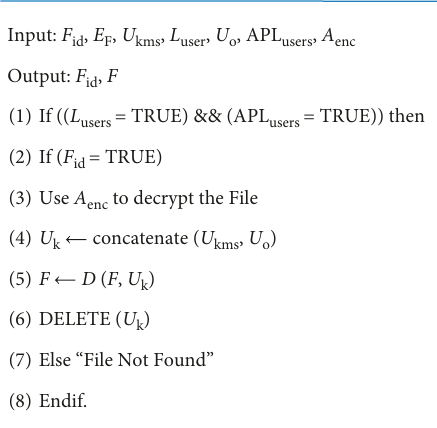
Figure 4: Decryption process by CKMS.